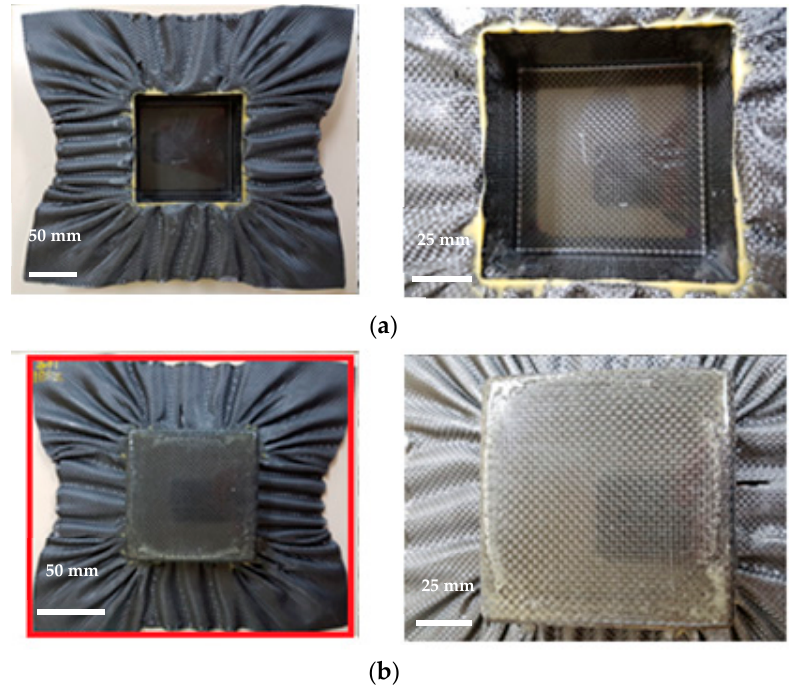
Figure 7. ( a ) Inner layer and ( b ) outer layer of the thermoformed square-cup for the Type 2 mold design with the pattern 1 prepreg laminate.